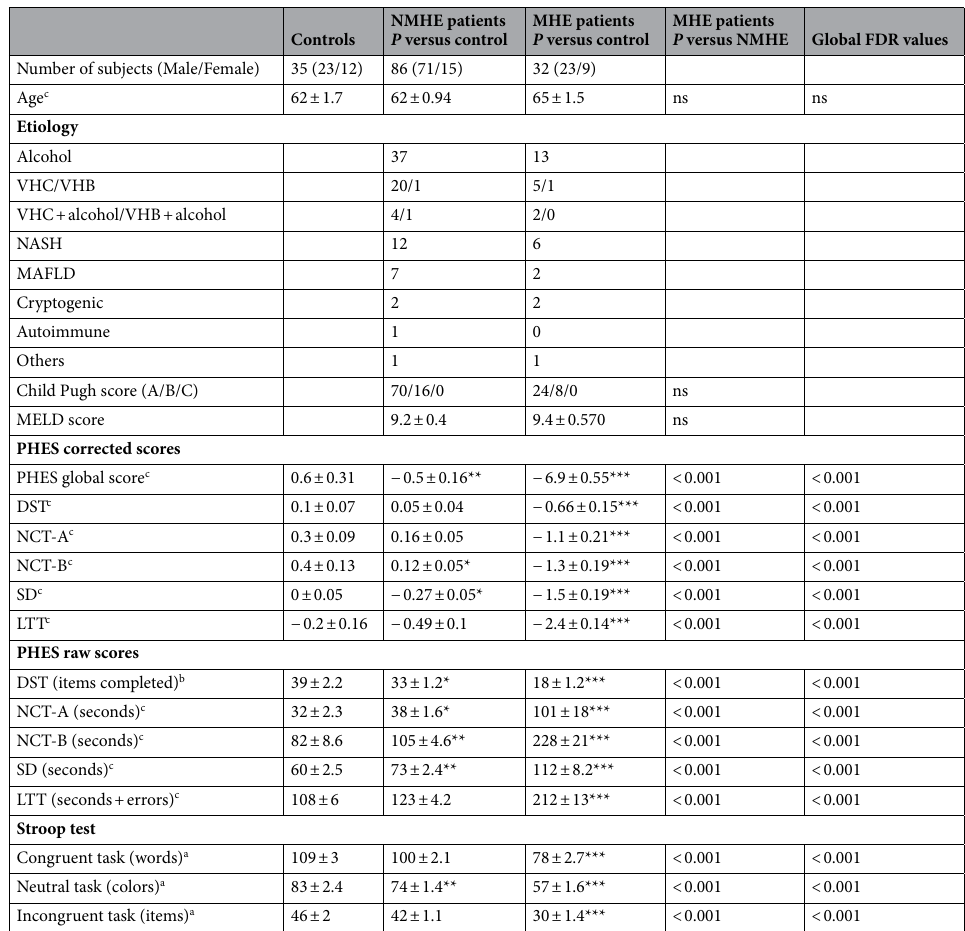
Table 1. Study sample data and performance of controls and patients in the neuropsychological tests performed. Values are expressed as mean ± SEM. Abbreviations: NMHE and MHE, patients without and with minimal hepatic encephalopathy according to PHES. MELD (Model for End-Stage Liver Disease) and Child Pugh Scores measure the severity of chronic liver disease. The higher the score is, the more severe the liver disease. VHB, VHC, hepatitis B and C viruses, respectively; NASH, Non-alcoholic steatohepatitis; MAFLD, Metabolic-associated fatty liver disease; PHES, Psychometric Hepatic Encephalopathy Score; DST, Digit Symbol Test; NCT-A, NCT-B: Number Connection Test A and B; SD, Serial Dotting Test; LTT, Line Tracing Test. Differences between groups were analyzed using one of three possibilities: one-way ANOVA followed by Tukey’s multiple comparison test (a) parametric and homoscedastic variables, Welch’s ANOVA followed by Games-Howell’s multiple comparison test (b) for parametric but non-homoscedastic variables, and Kruskal– Wallis followed by Dunn’s multiple comparison test (c) for non-parametric variables. Differences in MELD and Child Pugh scores were analyzed by unpaired t-test and Fisher’s exact test, respectively. Significant differences compared to controls are indicated by asterisks: * p < 0.05; ** p < 0.01; *** p < 0.001; ns,